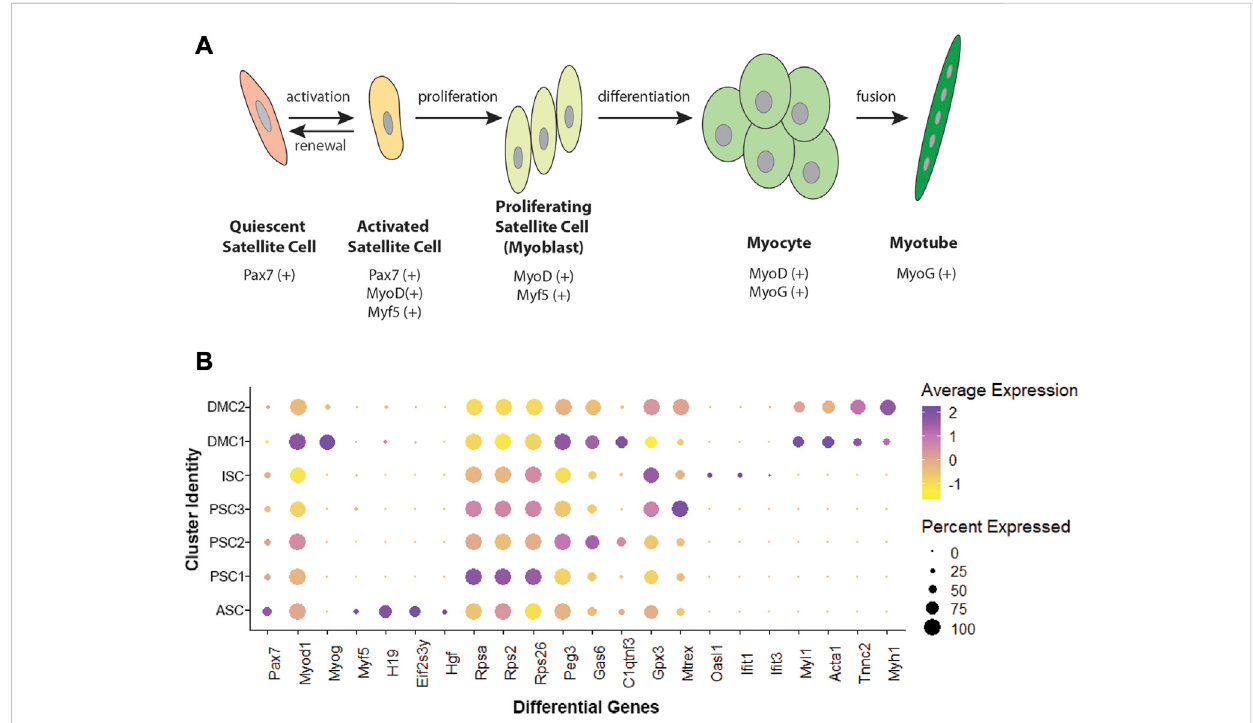
FIGURE 3 Myogenic transcription factors and differentially expressed genes in MuSCs. (A) Schematic of satellite cell progression to differentiated myotube, including the myogenic transcription factor pro fi le for each stage. (B) Dotplot showing average and percent expression of genes that differentiate the 7 cell clusters in PBS-treated